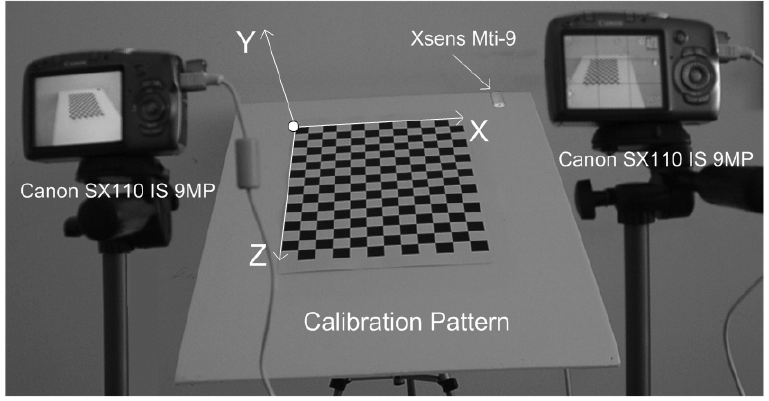
Figure 1. Experimental Setup and Rotating-Calibration